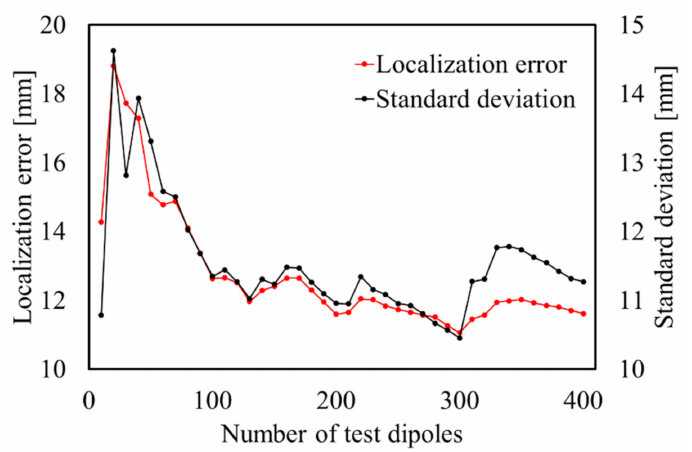
Figure 4. Estimated accuracy for each number of test dipoles with SNR = ∞ dB.